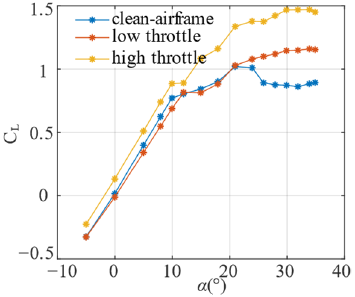
C  curves at two throttle statuses. Figure 13. Comparison of the C − α curves at two throttle L L